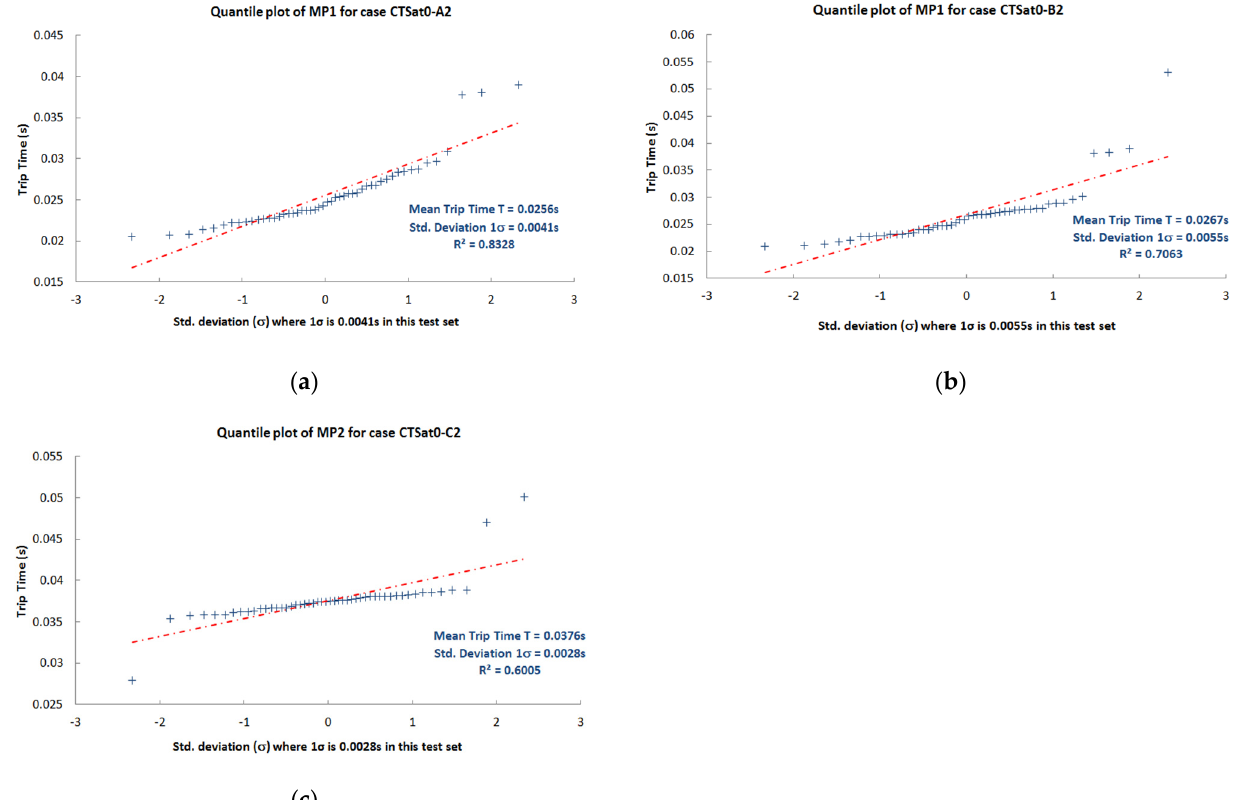
Figure 14. Quantile plot for cases: ( a ) CTSat0-A2 (ideal CT, no faulty component, 1Ph-G fault at 70% of the feeder); ( b ) CTSat0-B2 (ideal CT, 1 faulty fibre, 1Ph-G fault at 70% of the feeder); and ( c ) CTSat0-C2 (ideal CT, 1 faulty fibre, 1Ph-G fault at 70% of the feeder).